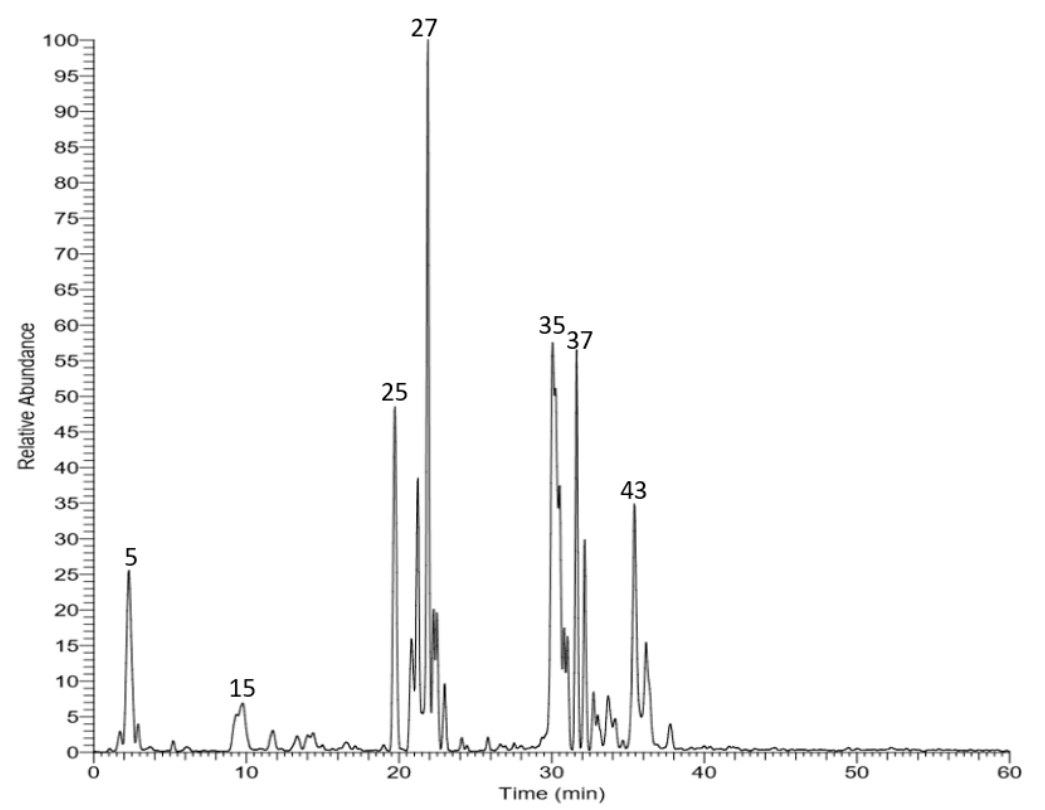
Figure 1. LC–MS profile of total methanol extract of grape leaves. Table 2. Chemical composition of methanol extract of grapes leaves.